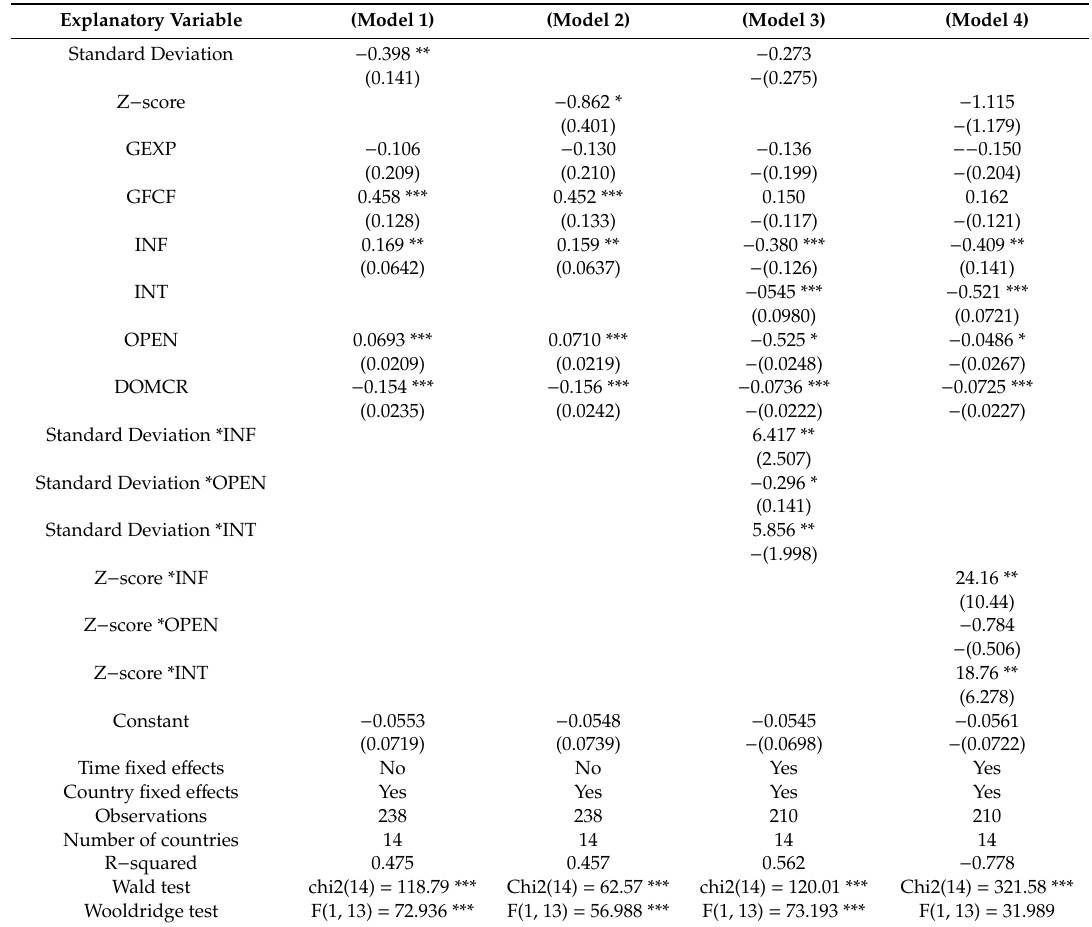
Table 4. Economic growth and exchange rate